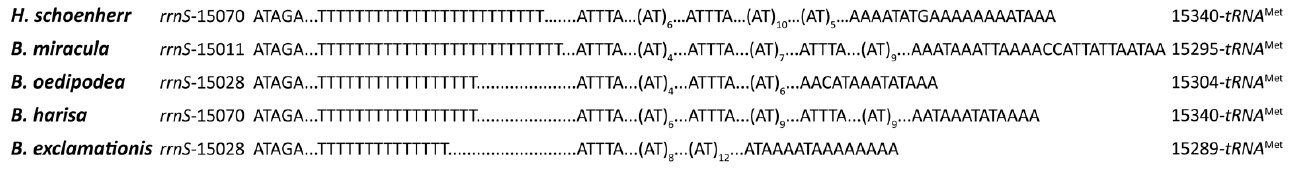
Figure 4. Structural elements found in the AT-rich region of five skippers (The presented nucleotides indicate the conserved sequences, dots between sequences indicate omitted sequences).